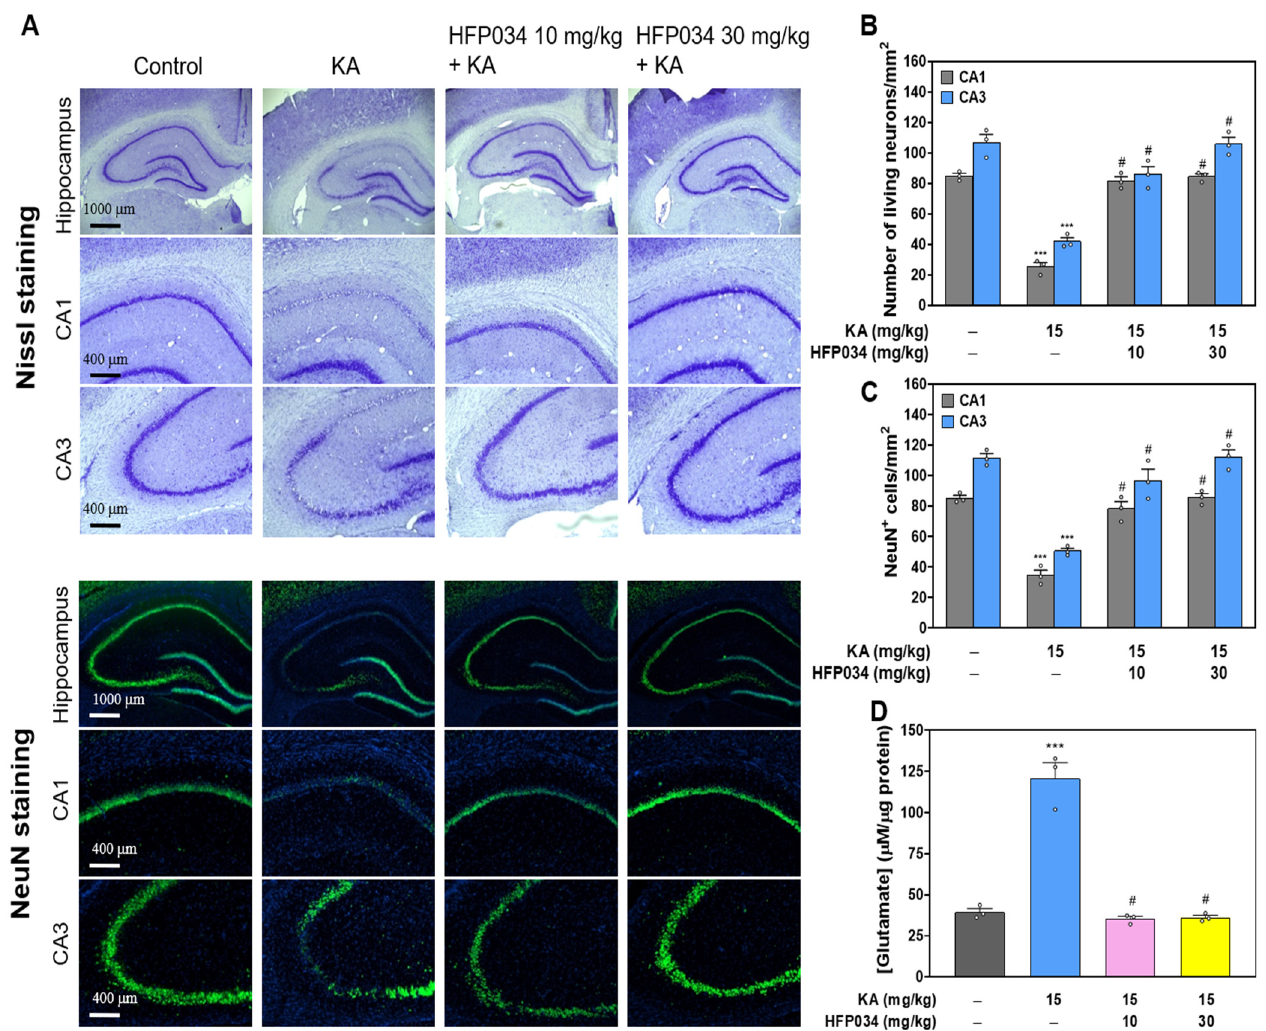
Figure 5. Effect of HFP034 pretreatment on the neuronal cell death and glutamate levels in the hippocampus of rats with KA. ( A ) Representative images of crystal violet and NeuN staining at 3 d after i.p. KA. ( B , C ) Quantitative data of A showing the number of living neurons and NeuN + cells in the hippocampal CA1 and CA3 regions. ( D ) The effect of HFP034 on the concentration of glutamate in the hippocampus of rats with KA. Each dot represents the value for an individual experiment. Data are presented as mean ± S.E.M. n = 3 rats for each group. *** p < 0.001, versus control group. # p < 0.001, versus KA group.